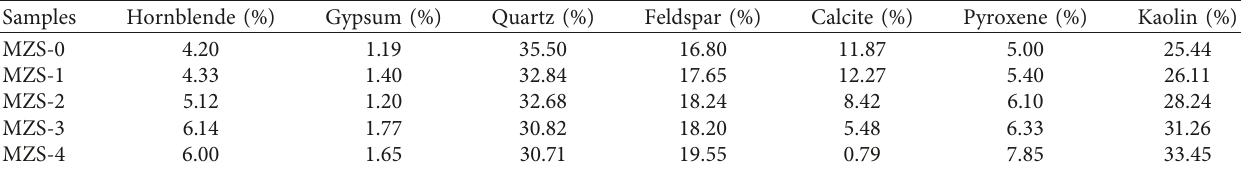
Table 2: Mineral composition of loess and treated loess samples.